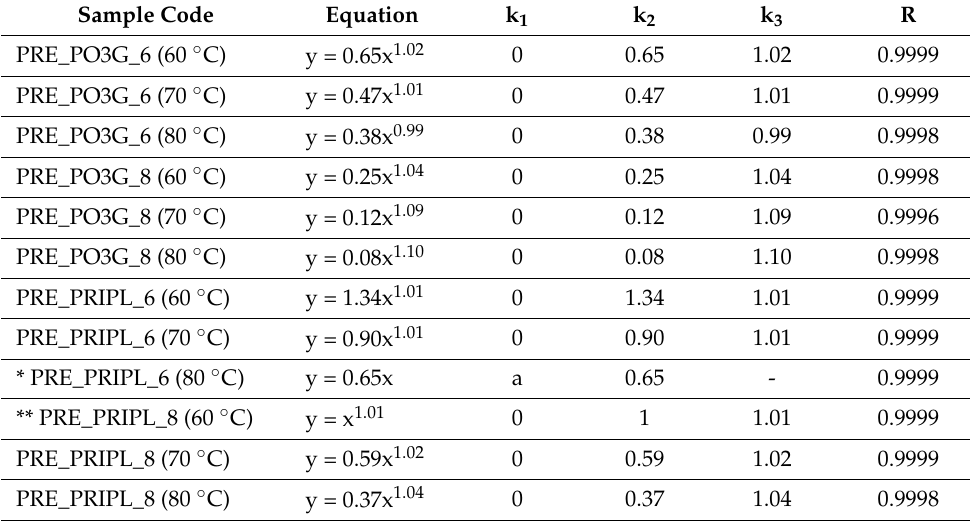
Table 2. Rheological model of the obtained prepolymers.